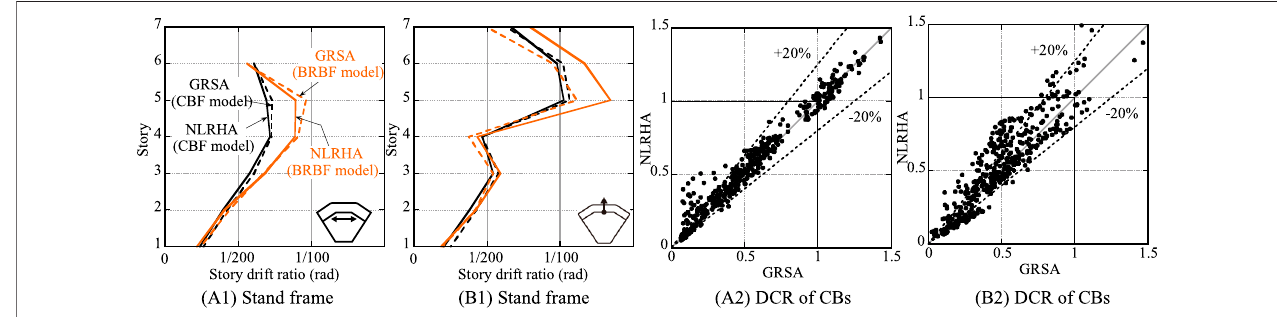
FIGURE 4 | Comparison of GRSAs and NLRHAs: (A) X-directional input, (B) Y-directional input.